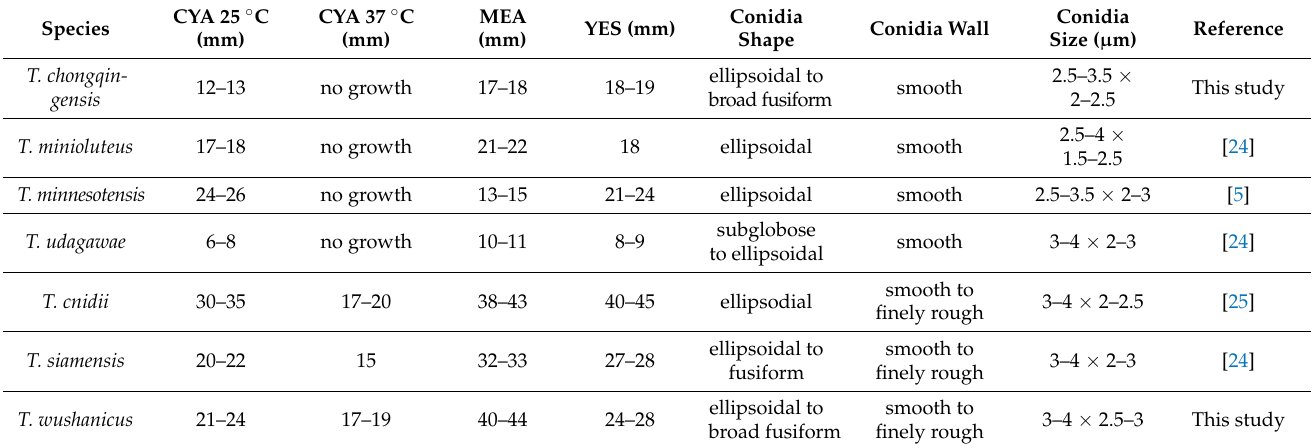
Table 5. Cultural and morphological comparisons of new species and their closely related species.